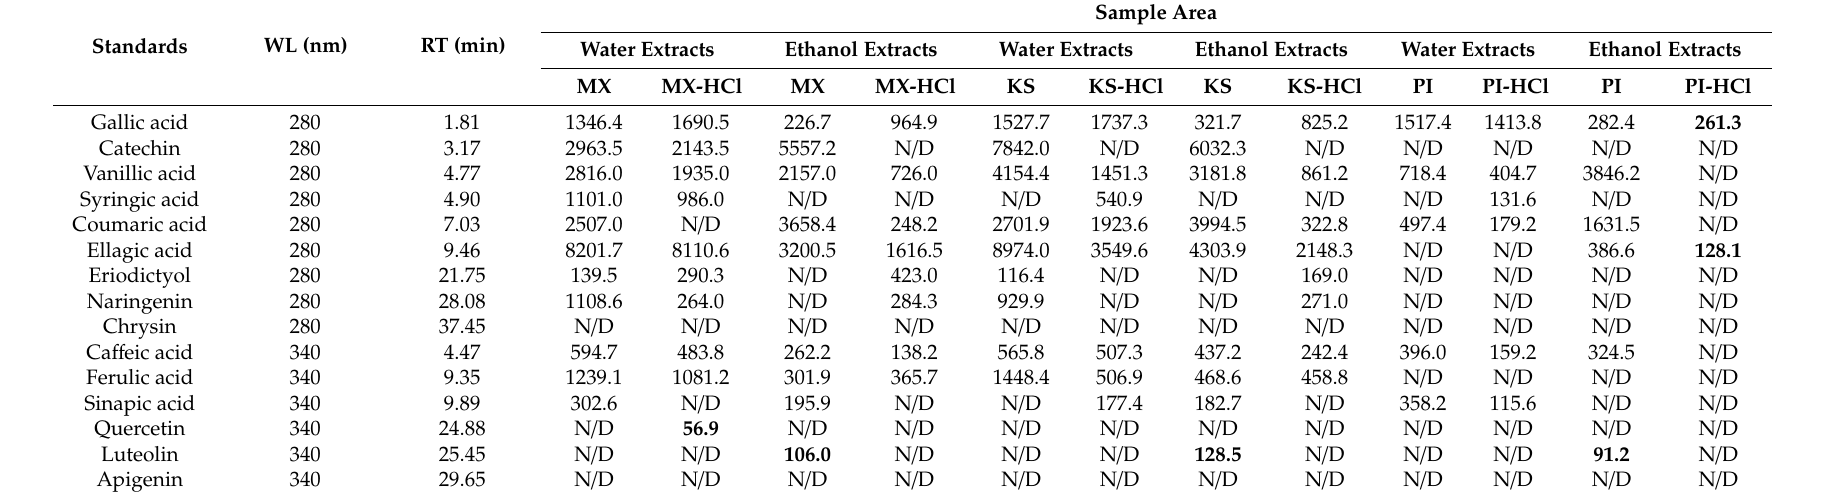
Table 2. Identification of flavones and flavanones in extracts of novel sorghum